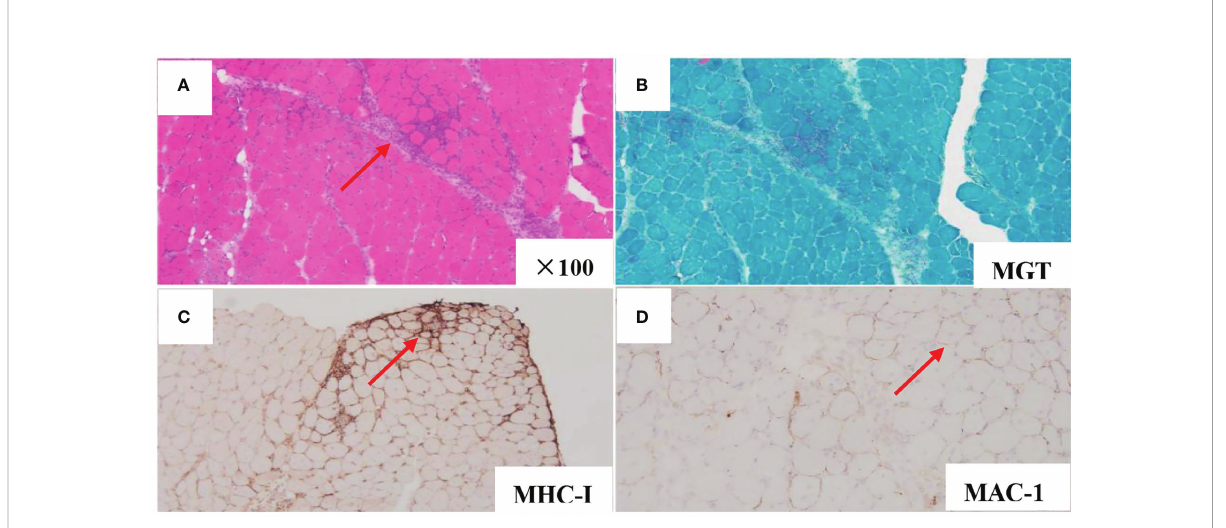
FIGURE 1 Muscle biopsy pathology analysis demonstrated chronic in fl ammatory cell in fi ltration in striated muscle tissue (HE stains, original magni fi cation×100) (A) . MGT (B) . MHC-I (small peribundle fi ber upregulation) (C) . MAC-1 (non-necrotic fi ber membrane deposition) (D)